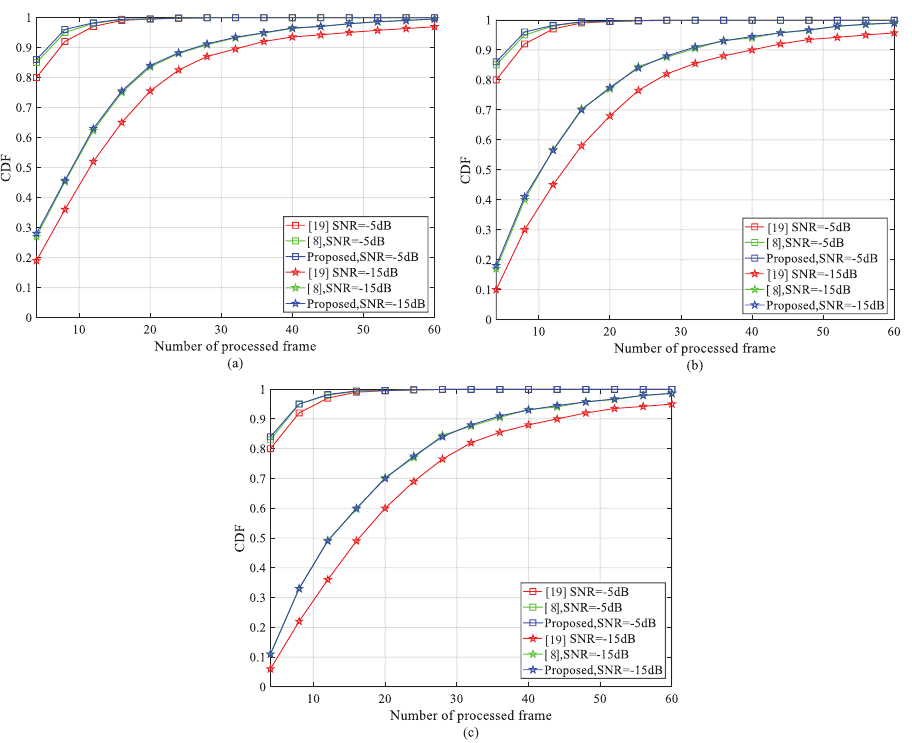
Figure 11. Comparison of the cumulative distribution function (CDF) for cell ID detection vs. the number of processed frames under normal coverage and extended coverage. ( a ) AWGN, ( b ) ETU-1Hz, ( c ) EPA-1Hz.